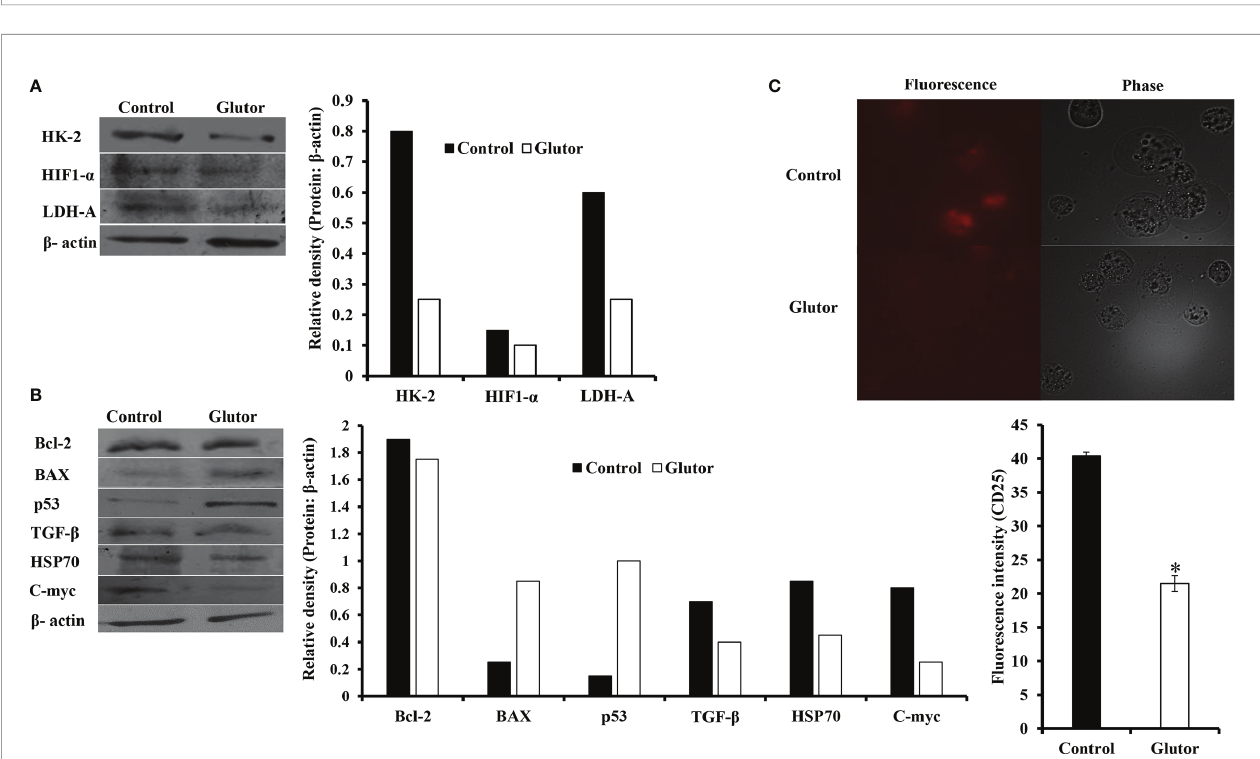
FIGURE 4 | Glutor modulates expression of metabolism and cell survival regulatory molecules in DL cells. DL cells (1 × 10 5 ) were incubated in a medium alone or containing glutor (0.01 µM) for 24 h, followed by Western blotting to study the expression of the indicated metabolism (A) , cell survival (B) regulatory molecules and CD25 (C) as described in the Materials and Methods section. The plates shown in (A – C) are from a representative experiment out of at least two experiments with similar results. The accompanying bar diagrams are densitometry of the respective bands.